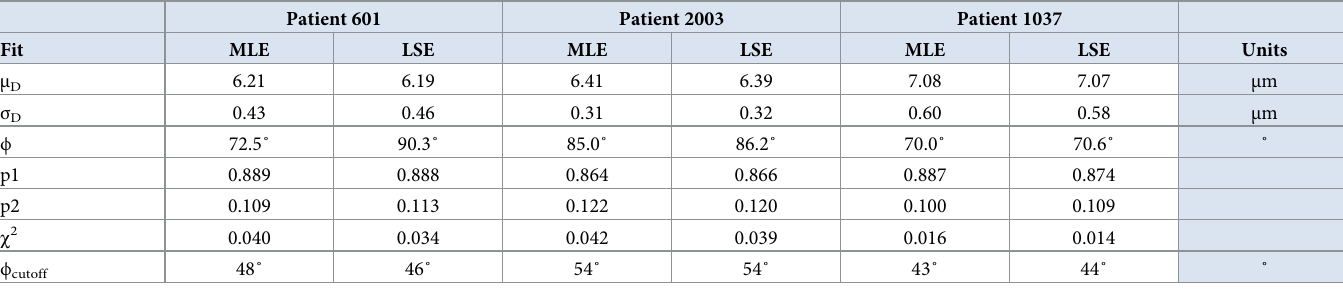
Table 4. Replication of the original Keiding-model fits to G(d) of human liver cell